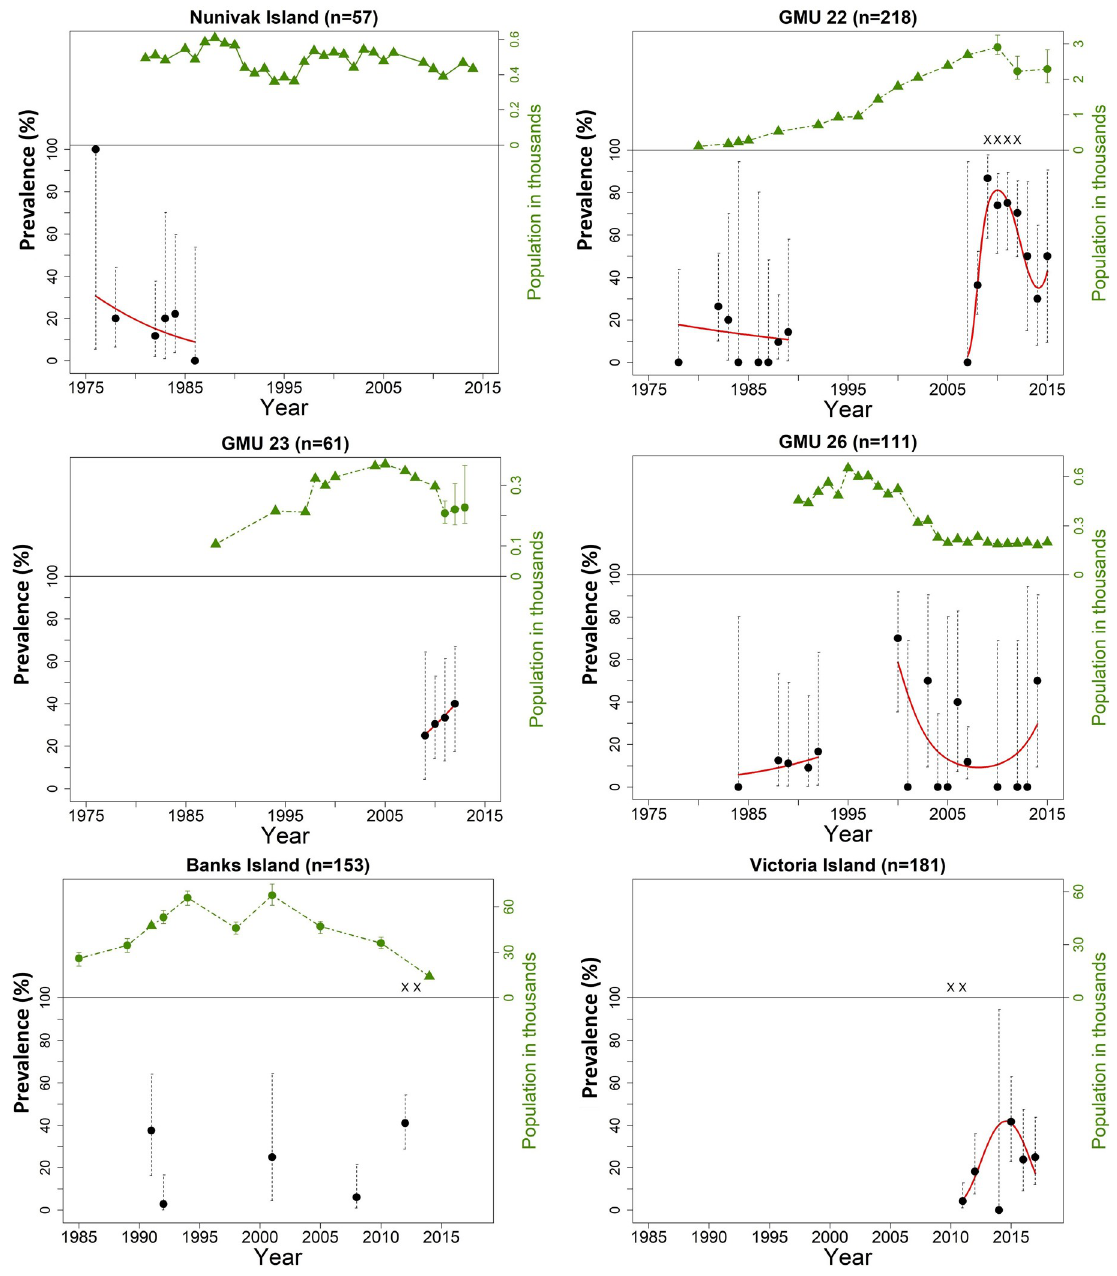
Fig 3. Time plots of seroprevalences to Erysipelothrix rhusiopathiae in North American muskoxen. Time plots of seroprevalences (black dots) to Erysipelothrix rhusiopathiae from a set of 781 muskoxen sampled in six regions of Alaska and Canada. Dotted vertical lines represent exact binomial confidence intervals. Red curves represent trend lines for regions and time periods (see text for the calculations of trends in seroprevalences). Population trends as estimated through aerial surveys are indicated in green in the top part of each plot (with 95% Confidence Intervals represented by green dotted lines) and documented mortality events with detection of E . rhusiopathiae are depicted with an X (see Table 1 for references).